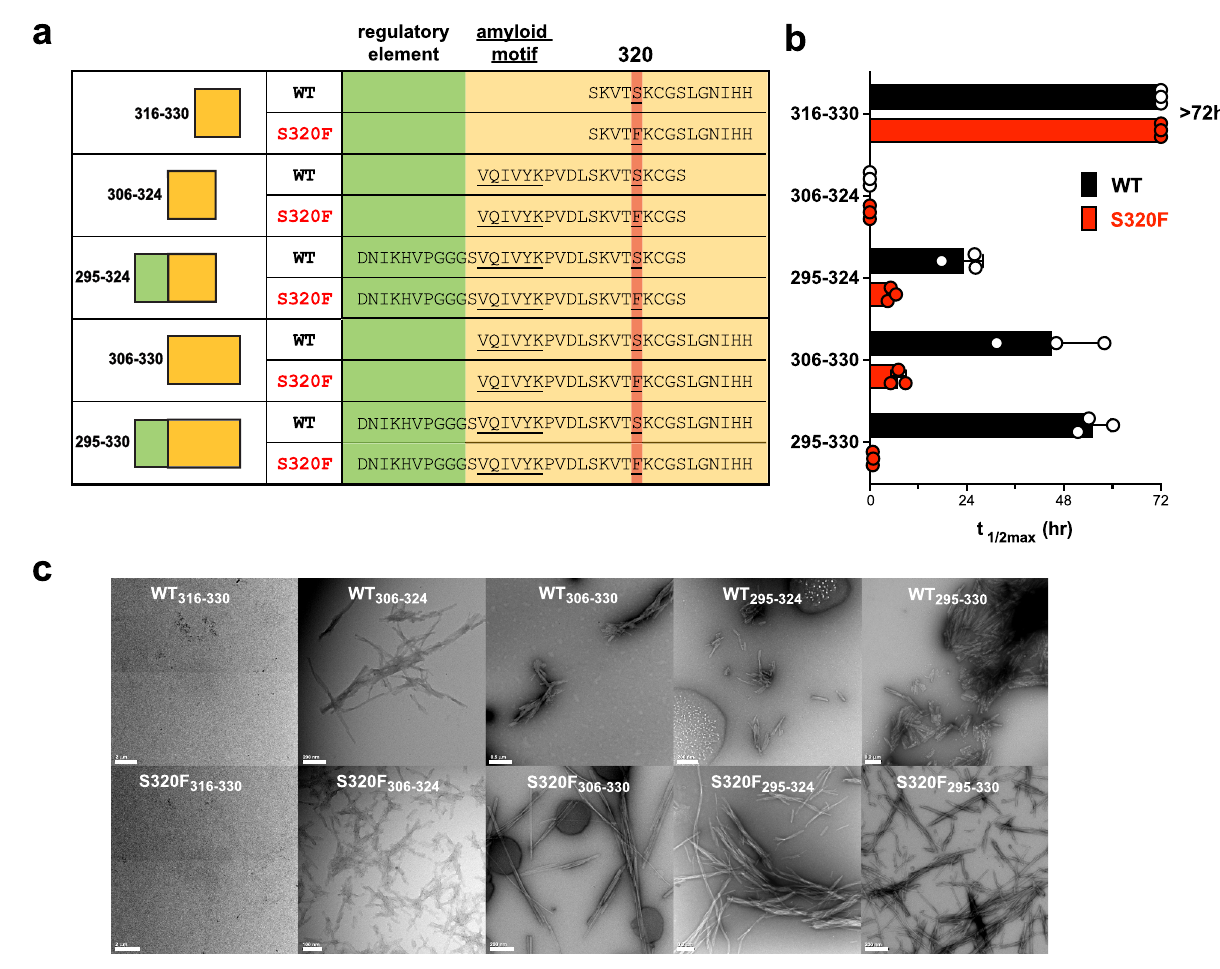
Fig. 2 | VQIVYK is essential in S320F facilitated aggregation, and the sur- rounding sequence regulates aggregation. a Design of sequence fragments encompassing 320 positions in WT or S320F context. The 320 position and 306 VQIVYK 311 are underlined. b ThT fl uorescence signal at 72h for each